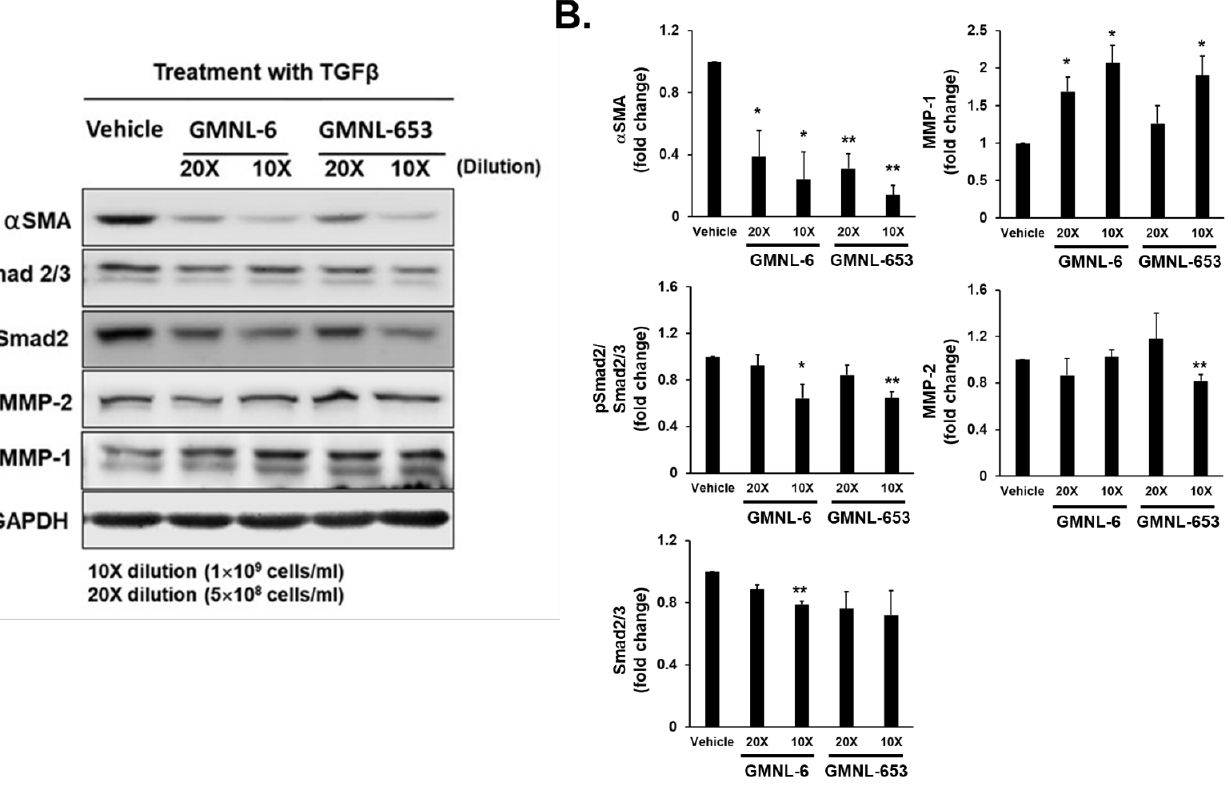
Figure 2. The heat-killed probiotics GMNL-6 or GMNL-653 preparation inhibits the TGF- β induced phosphorylation of Smad2 but increases the expression of MMP1 in Hs68 cells. Hs68 fibroblast cells were seeded onto 6-well-plates at a density of 2 × 10 5 cells/well and treated with 20 ng/mL TGF-β in combination with the heat-killed GMNL-6 or GMNL-653 preparations at 10 fold (10×, 1 × 10 9 cells/mL) or 20 fold (20×, 5 × 10 8 cells/mL) dilution for 48 h. The proteins expressions of α-smooth muscle actin (αSMA), phosphorylated Smad2, total Smad2/3, MMP-1, or MMP-2 were determined by western blot analysis ( A ) and the bar graphs presented in ( B ) were resulted from two independent experiments. * p < 0.05; ** p < 0.01.